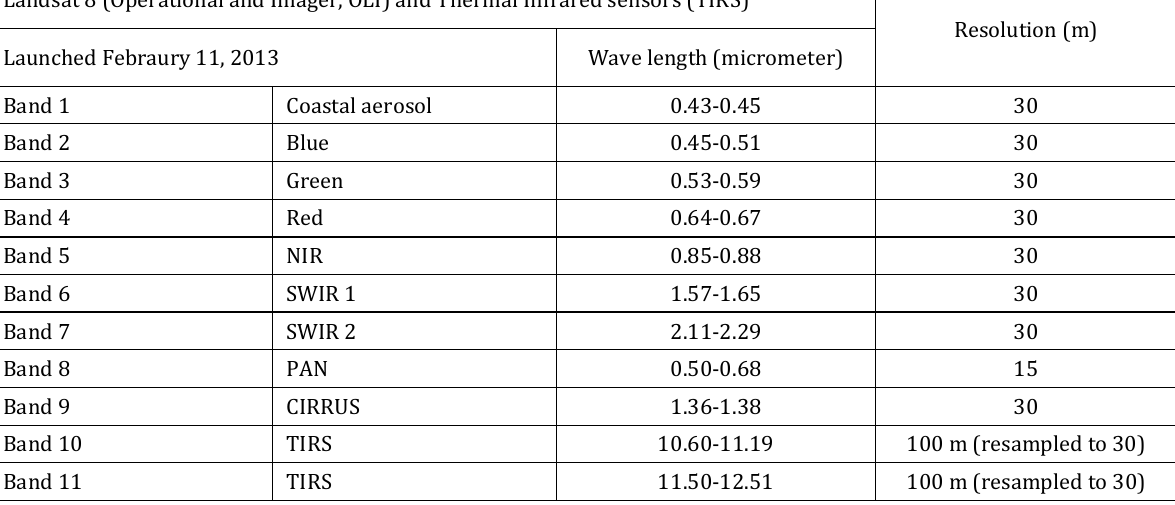
Table 1. Details about Landsat - 8